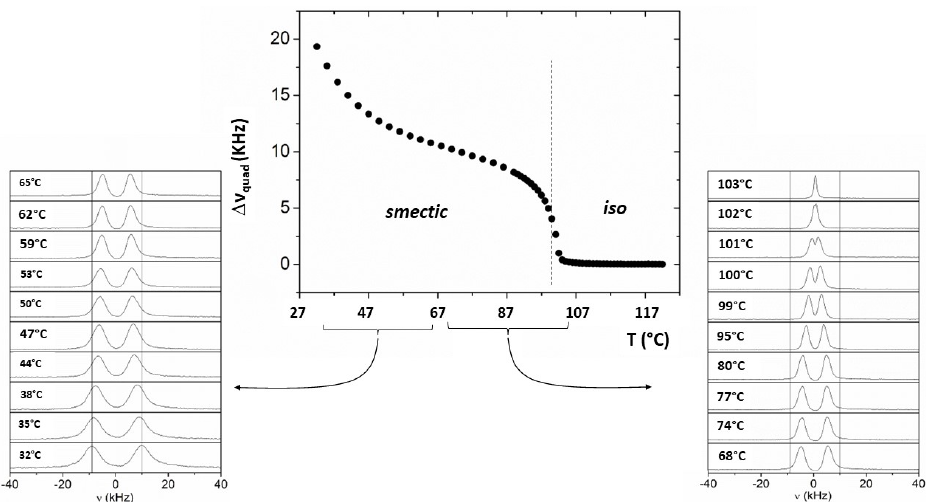
Figure 9. On the left and on the right: selection of 2 H NMR spectra of the deuterated SC-LCE 2 ( D ) sample recorded on cooling from the isotropic phase to room temperature. Vertical lines on the two spectral stackplots (from 103 °C to 68 °C and from 65 °C to 32 °C) are eye guidelines. In the center: temperature dependence of the quadrupolar splitting, Δν quad . The vertical dotted line indicates the temperature transition as observed by 2 H NMR spectroscopy.